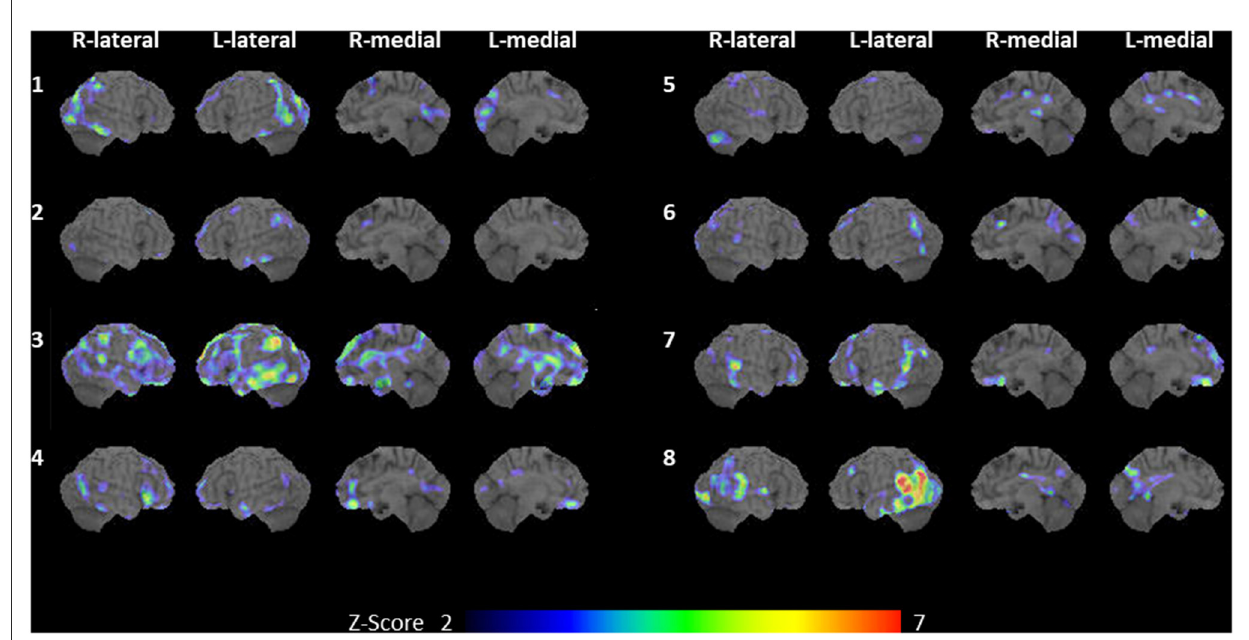
FIGURE2 Brain SPECT. IMP-SPECT analyzed with 3D stereotactic surface projections revealed patterns of significant hypoperfusion in each of the eight cases with an aphasic MCI-LB. Case numbers are shown to the left of each set of images. Cases 1–5: progressive anomic aphasia; cases 6–8: logopenic progressive aphasia. L, left; R, right; aphasic MCI-LB, aphasic mild cognitive impairment with Lewy bodies; IMP-SPECT, N -isopropyl-p-[ 123 I] iodoamphetamine single-photon emission computed